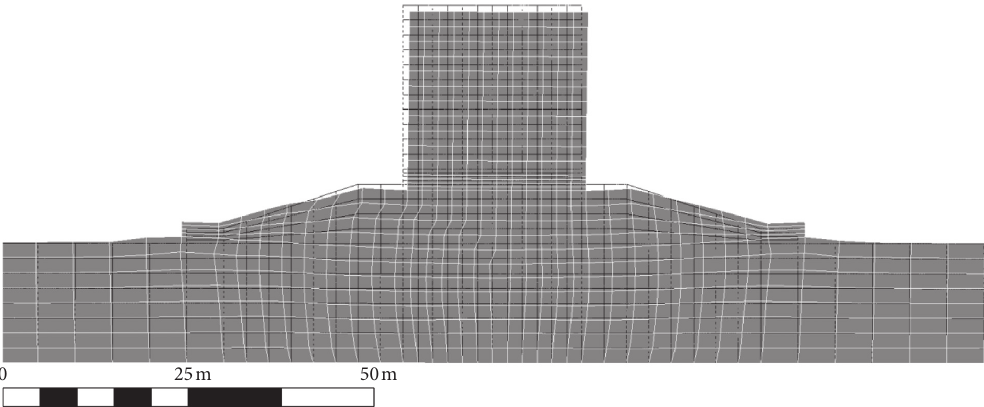
Figure 18: Deformation of whole breakwater system ( × 20